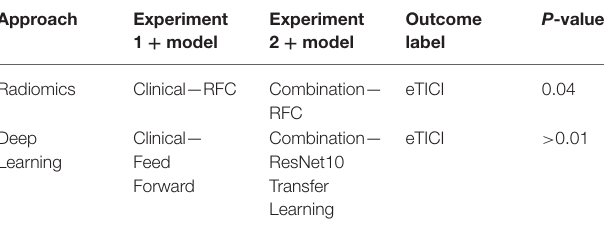
TABLE 6 | Delong’s test results for the best performing models from